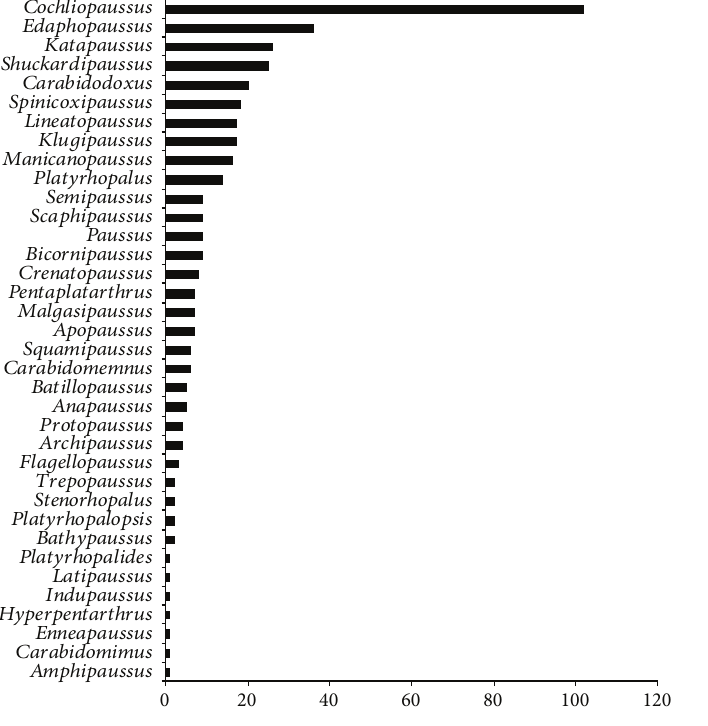
Figure 11: Number of species per subgenus in the tribe